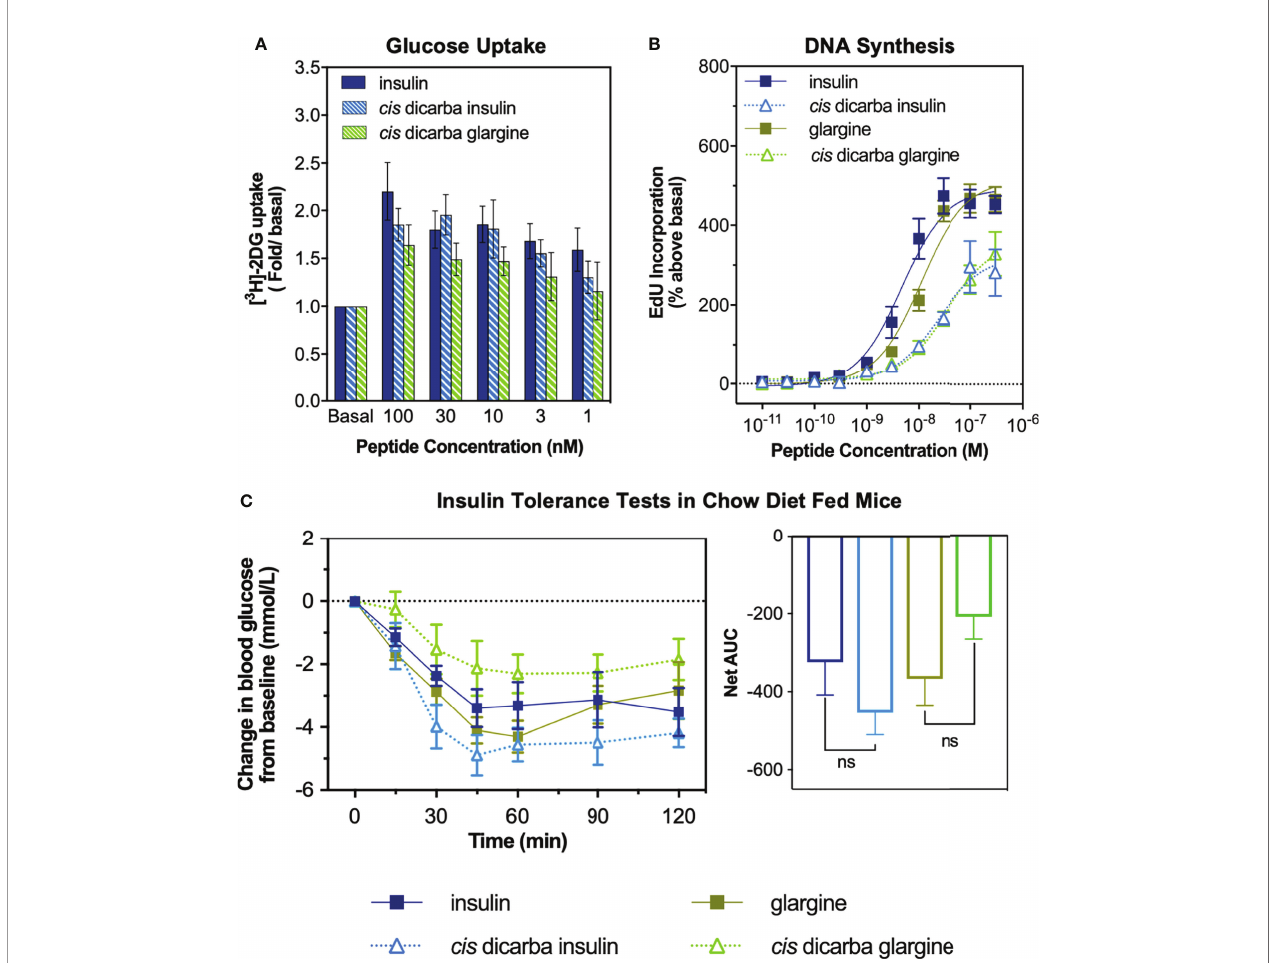
FIGURE 3 | In vitro metabolic and mitogenic studies of insulin, glargine and cis -dicarba analogues. (A) Glucose uptake stimulated by increasing concentrations of insulin, cis- dicarba insulin or cis- dicarba glargine is expressed as fold 2-deoxyglucose (2-DG) uptake (pmol/min/mg) above basal. Insulin vs cis -dicarba insulin vs cis- dicarba glargine (ns) (paired T-test ). (B) DNA synthesis in response to increasing concentrations of stimulating insulin analogue is shown as percentage incorporation of 5-Ethynyl-2 ’ -uridine (EdU) above basal. All data in (A) and (B) are the mean ± S.E.M. n = at least 3 independent experiments. (C) Insulin tolerance tests were conducted in mice fed on a normal diet (chow). Insulin, glargine, cis -dicarba insulin or cis- dicarba glargine (0.75 IU/kg) were administered through intraperitoneal injection (ip) under non-fasting conditions and tail vein blood glucose was measured via glucose meter at indicated times. n = 5-6 per group. Blood glucose levels are expressed as change over basal levels (mmol/L). AUC, area under the curves. Chow diet: insulin vs cis- dicarba insulin ns ; glargine vs cis- dicarba glargine ns (paired T-test ). Error bars for all graphs are shown when greater than the size of the